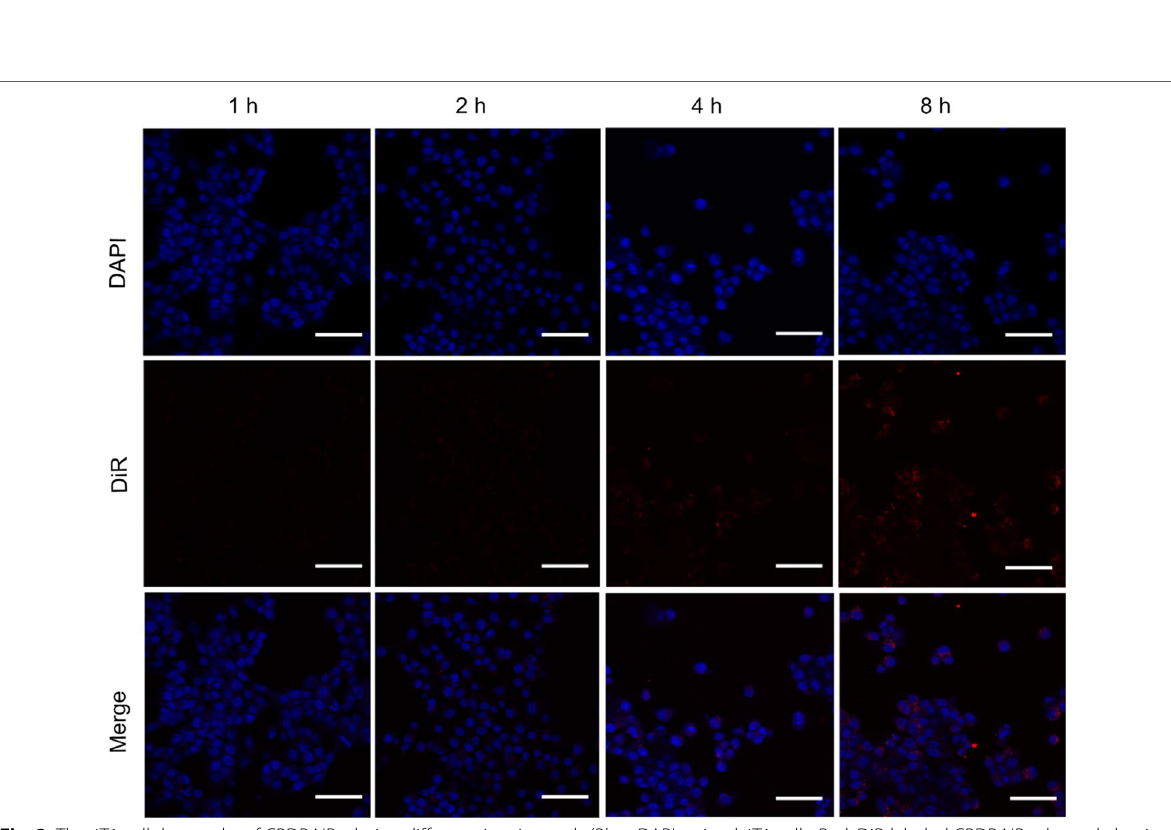
Fig. 3 The 4T1 cellular uptake of CPDP NPs during different time intervals (Blue: DAPI stained 4T1 cells. Red: DiR-labeled CPDP NPs, the scale bar is 50